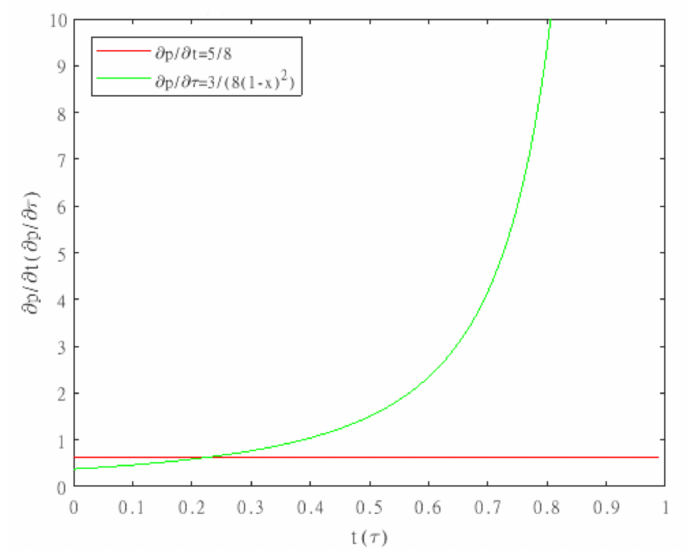
Figure 8. Price change rate for the final product of firms in the downstream country in response to changes in the ad valorem tax and specific